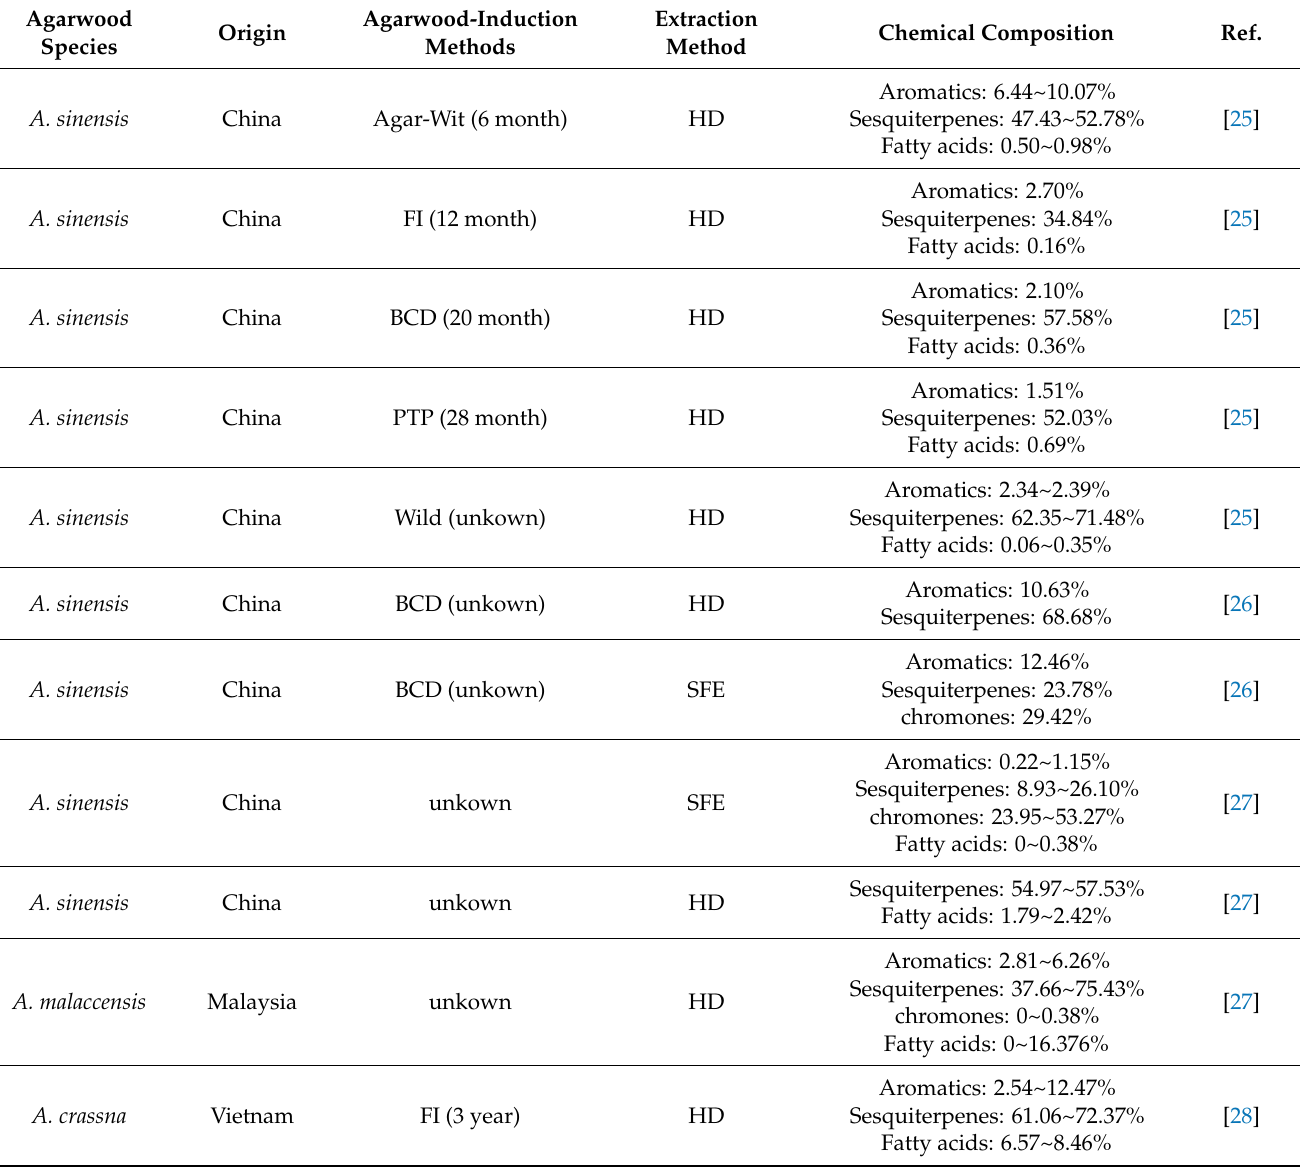
Table 1. Composition of chemical constituents in different